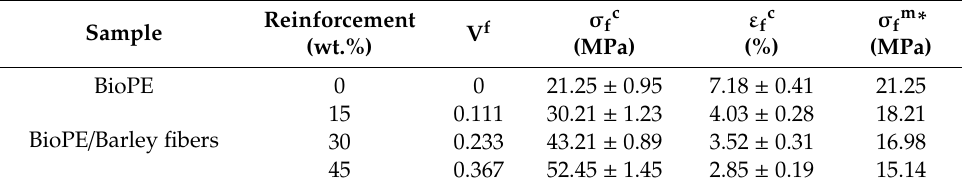
Table 2. Flexural properties of BioPE composites reinforced with barley fibers .